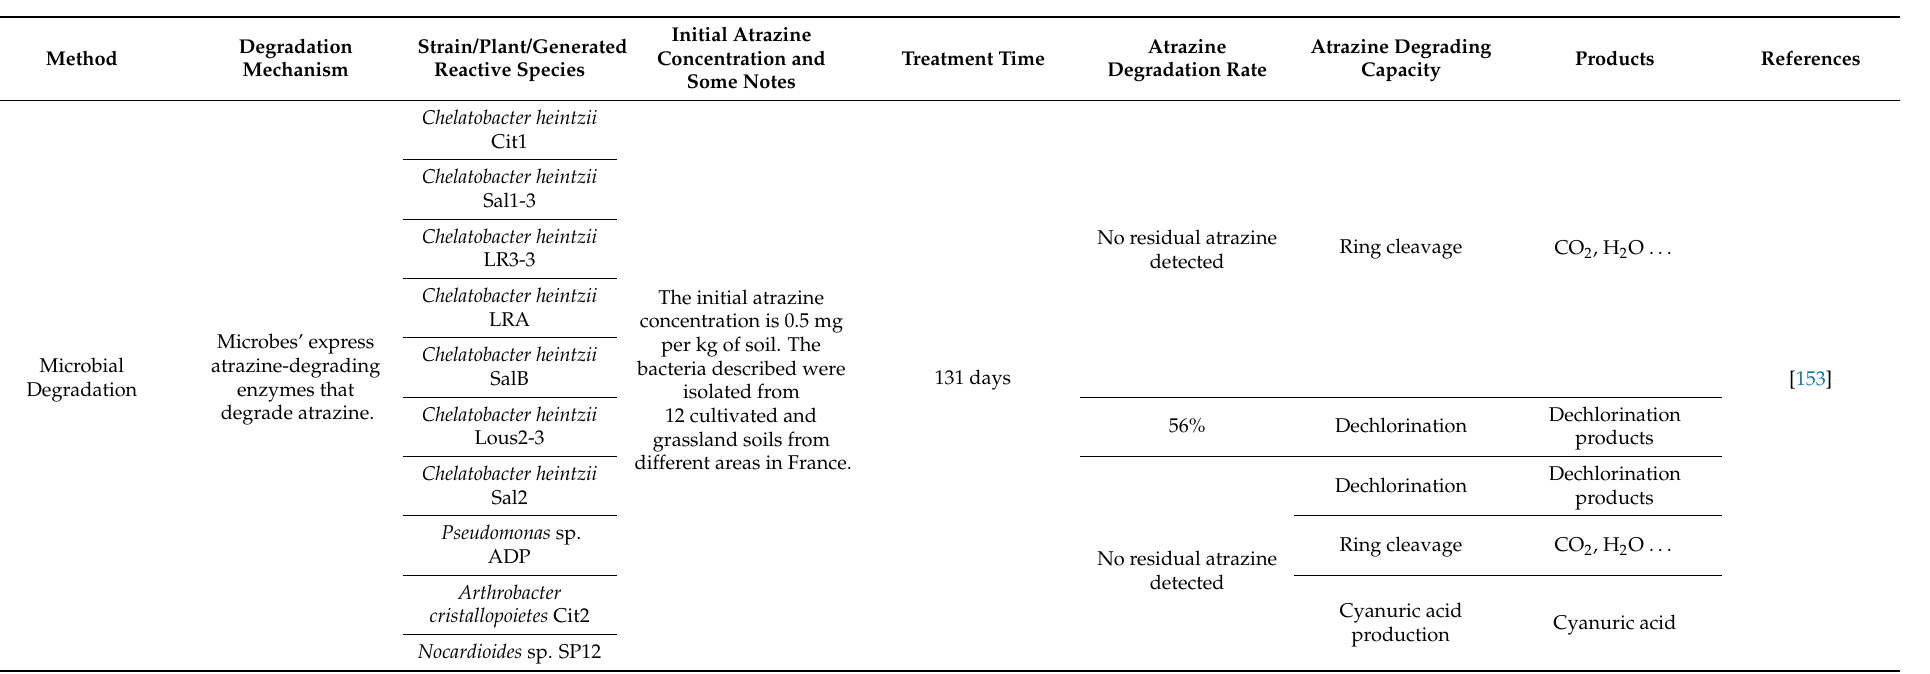
Table A1. Comparison of different methods (degradation mechanism, atrazine degradation rate, atrazine mineralization rate and main